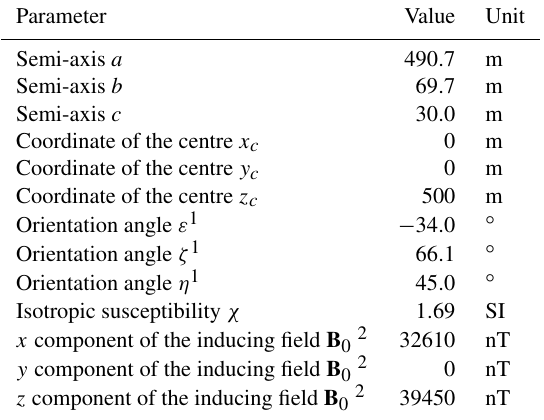
Table 2. Parameters defining a synthetic orebody. This model is based on that presented by Farrar (1979) to simulate the Warrego orebody, Tennant Creek field, Australia.